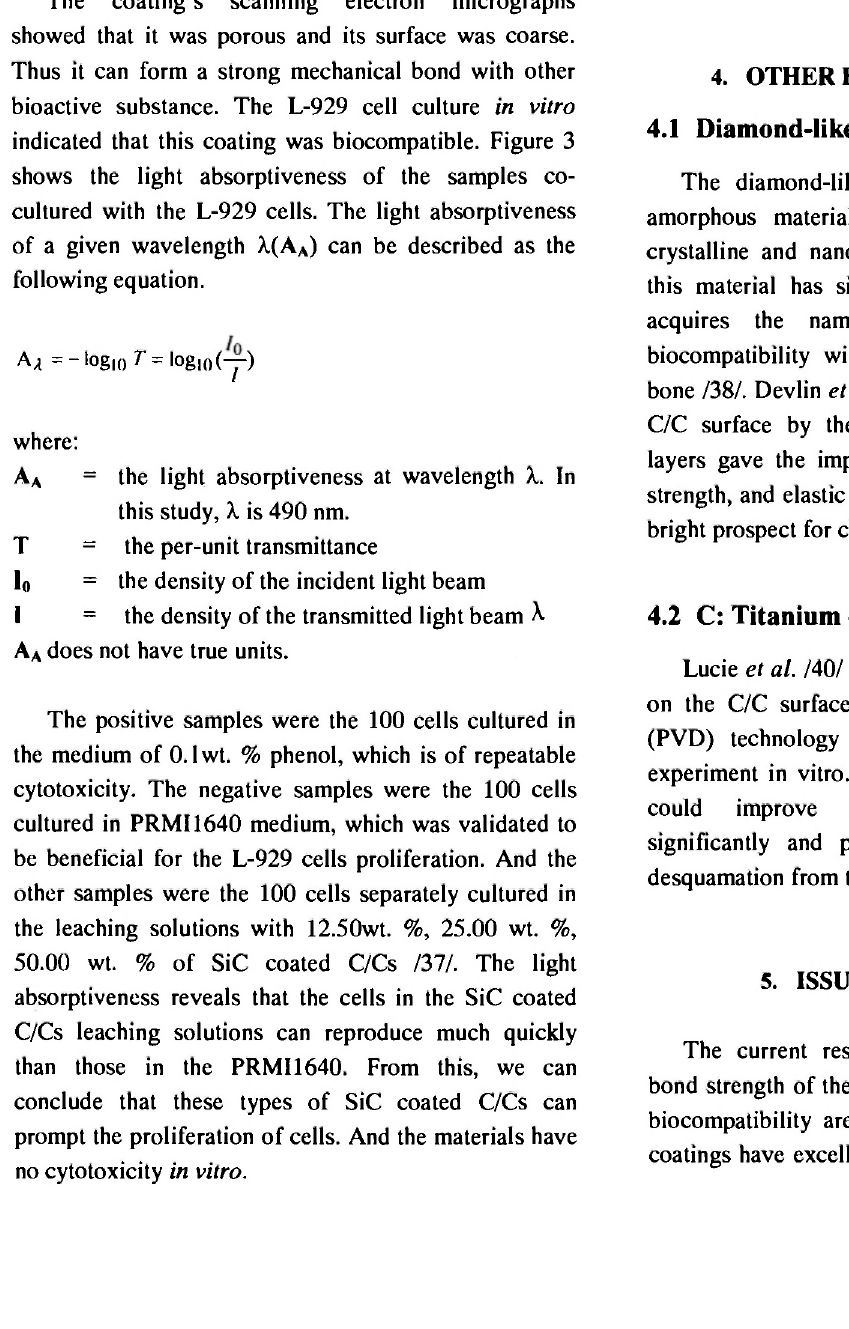
Fig. 3: the light absorptiveness of the